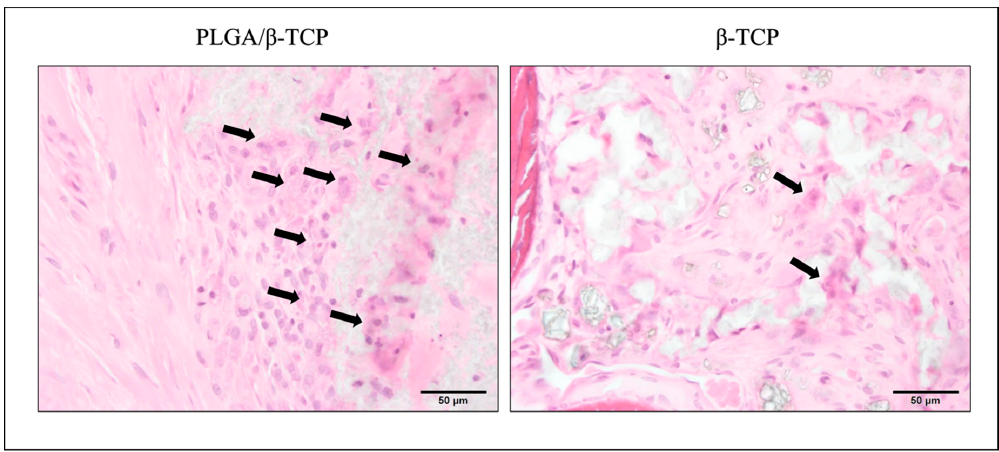
Figure 4. Histological analysis at 12 weeks post-operative. ( a – c ) toluidine blue stained sections; ( d – f ) HE stained sections.